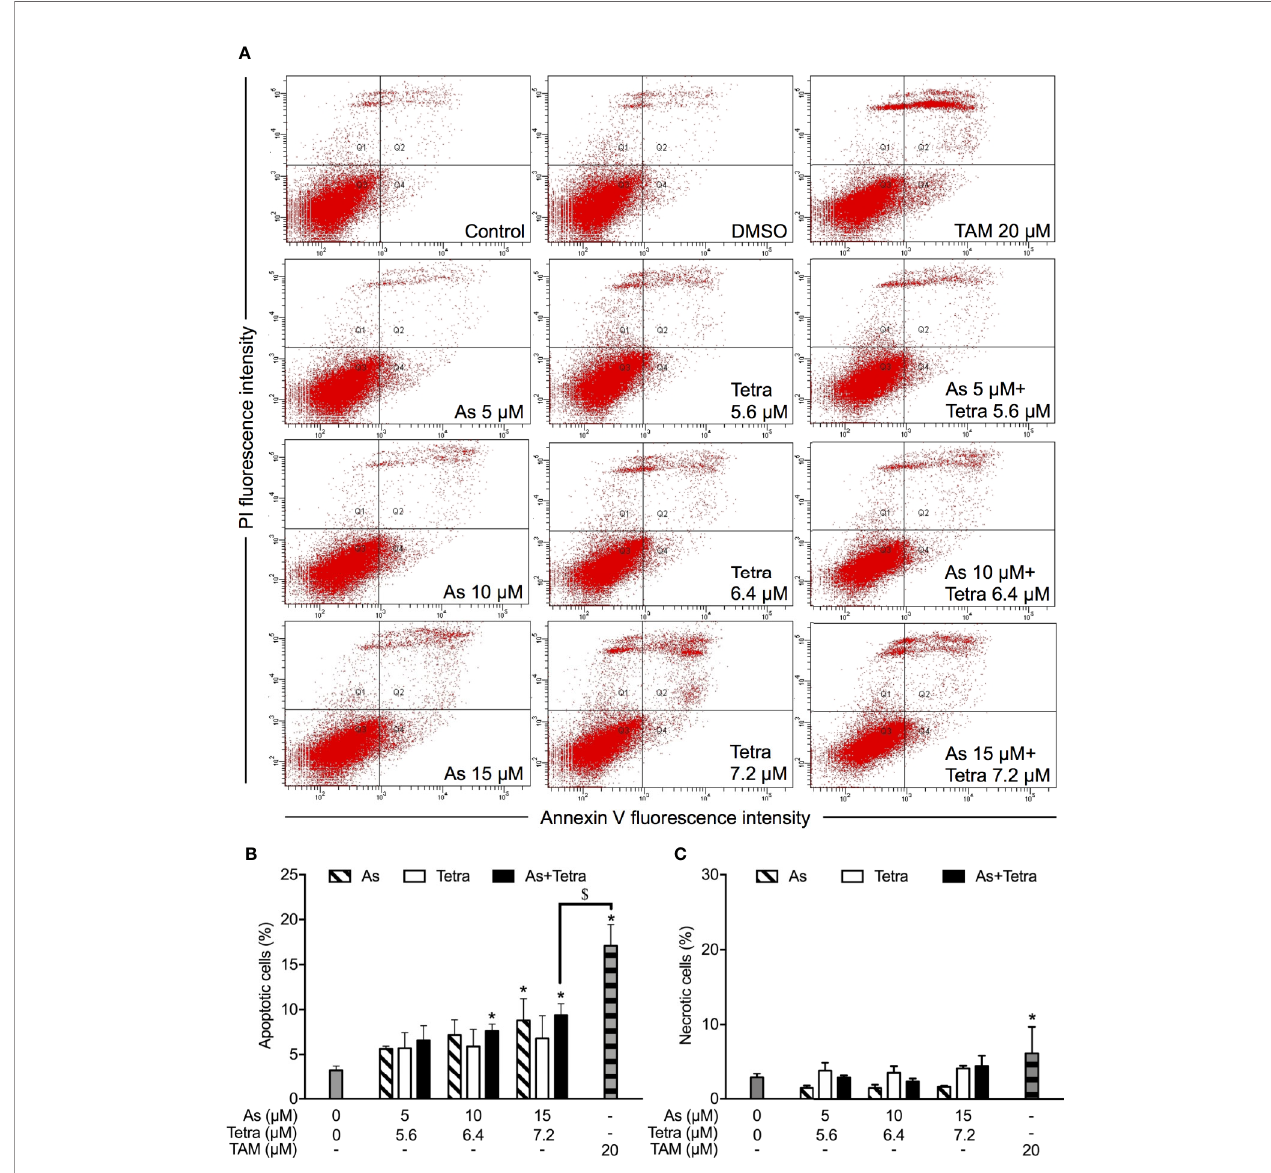
FIGURE 3 | Induction of apoptotic and necrotic cell death in T47D cells by As III combined with Tetra. (A) After treatment with indicated concentrations of As III and Tetra, alone or in combination, for 48 h, cells were stained with annexin V-FITC and PI, and analyzed by fl ow cytometry. Annexin V( − )PI( − ) cells, annexin V(+)PI( − ) cells, annexin V(+)PI(+) cells, and annexin V( − )PI(+) cell represent viable cells, early apoptotic cells, late apoptotic/necrotic cells, and necrotic cells, respectively. (A) Representative dot plots from three independent experiments are shown. Quanti fi cations in the percentages of apoptotic cells (B) and necrotic cells (C) are shown, respectively. *p<0.05 vs. control; $ p<0.05 vs. TAM. TAM (20 µM) used as an inducer (positive control) for the induction of apoptosis and necrosis. As, As III ; Tetra, tetrandrine; TAM,